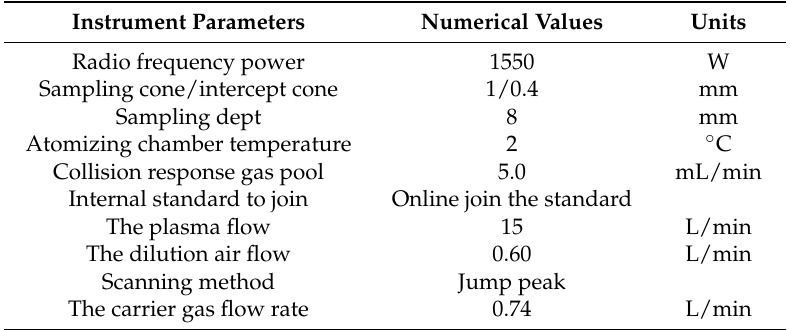
Table 2. ICP-MS instruments working conditions of